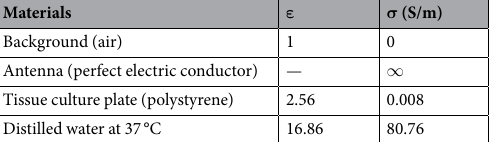
Table 1. Relative permittivity and electrical conductivity of materials used in